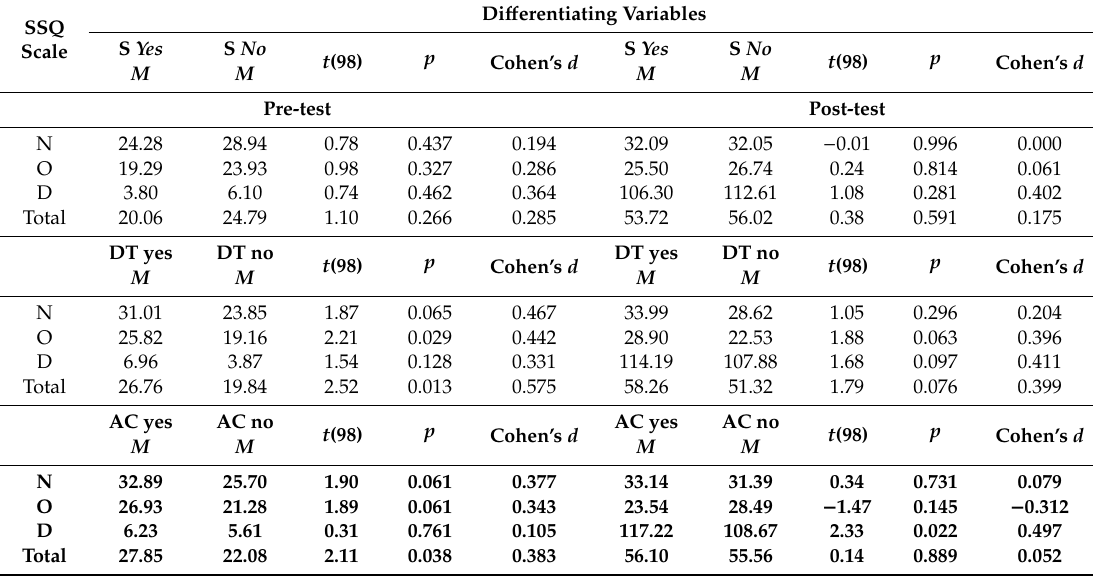
Table 4. Di ff erences between pre-test and post-test SSQ scores in participants with and without prior simulation experiences, extra driving training, and accidents or collisions—the results of t -test. Di ff erentiating SSQ Scale